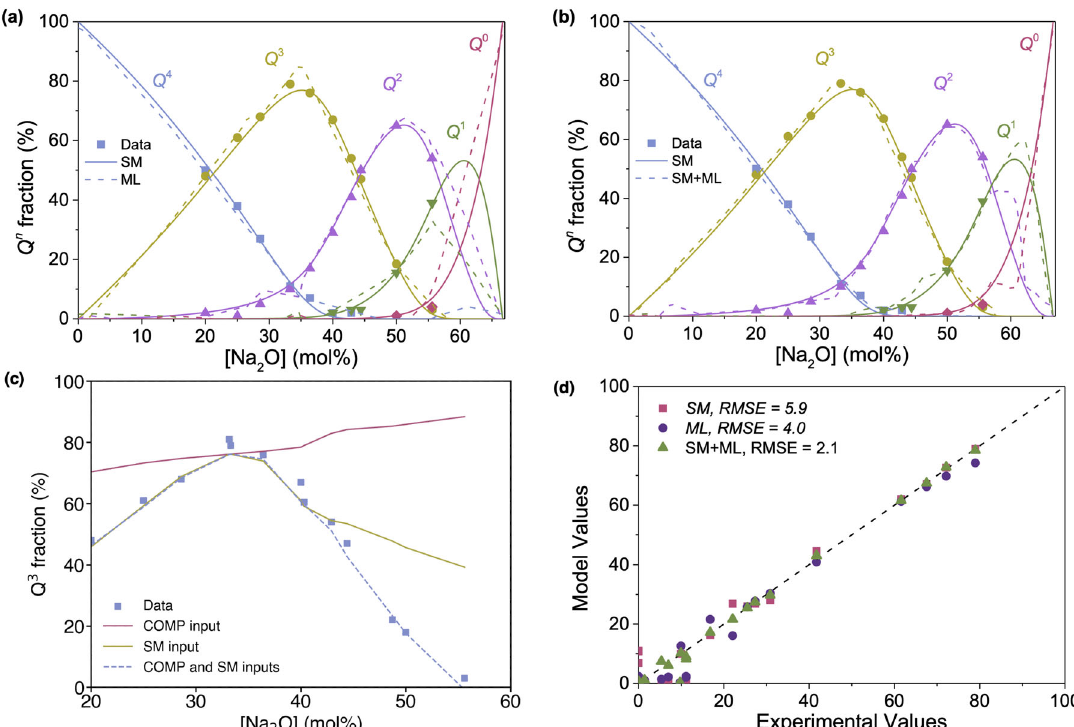
Fig. 5 Model predictions of Q n fractions in sodium silicate glasses. a , b Q n fractions as a function of Na 2 O concentration in the Na 2 O – SiO 2 glass system. The symbols represent experimentally obtained data from the literature 37 , solid lines represent modeling results obtained by statistical mechanics (Approach 1), and the dashed lines represent modeling results obtained with ( a ) MLP-NN (Approach 2) and b statistical mechanics informed MLP-NN model (Approach 3). c Q 3 fractions as a function of Na 2 O concentration in the Na 2 O – SiO 2 glass system predicted by the statistical mechanics informed MLP-NN model (Approach 3) when using either the chemical composition (COMP input), statistical mechanics (SM input) or a combination thereof as input (COMP and SM inputs). d Blind model prediction plotted against experimentally obtained data from literature 38 for each of the three modeling